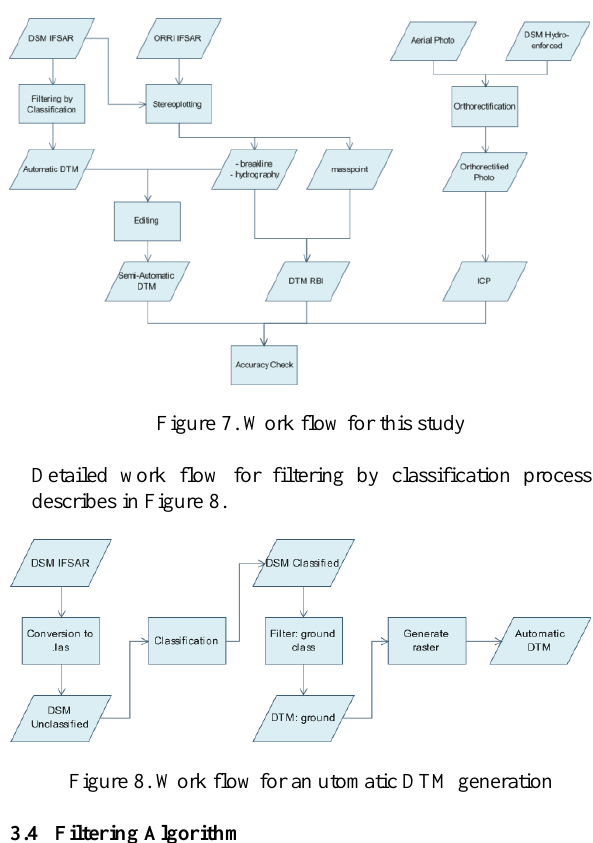
3.3 Data Processing Work Flow